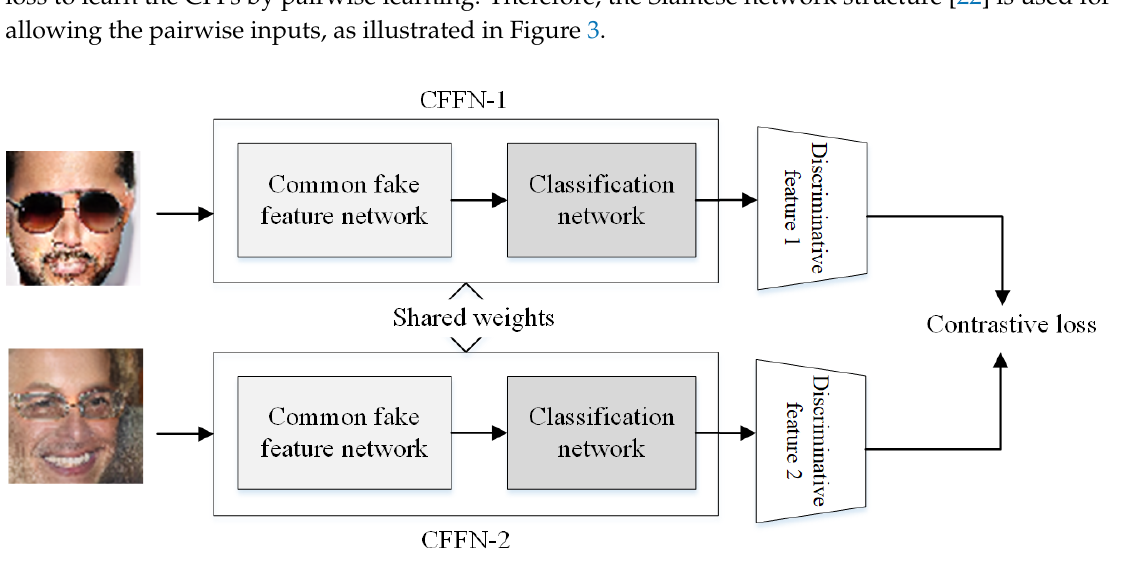
Figure 3. The proposed pairwise learning based on the Siamese network and contrastive